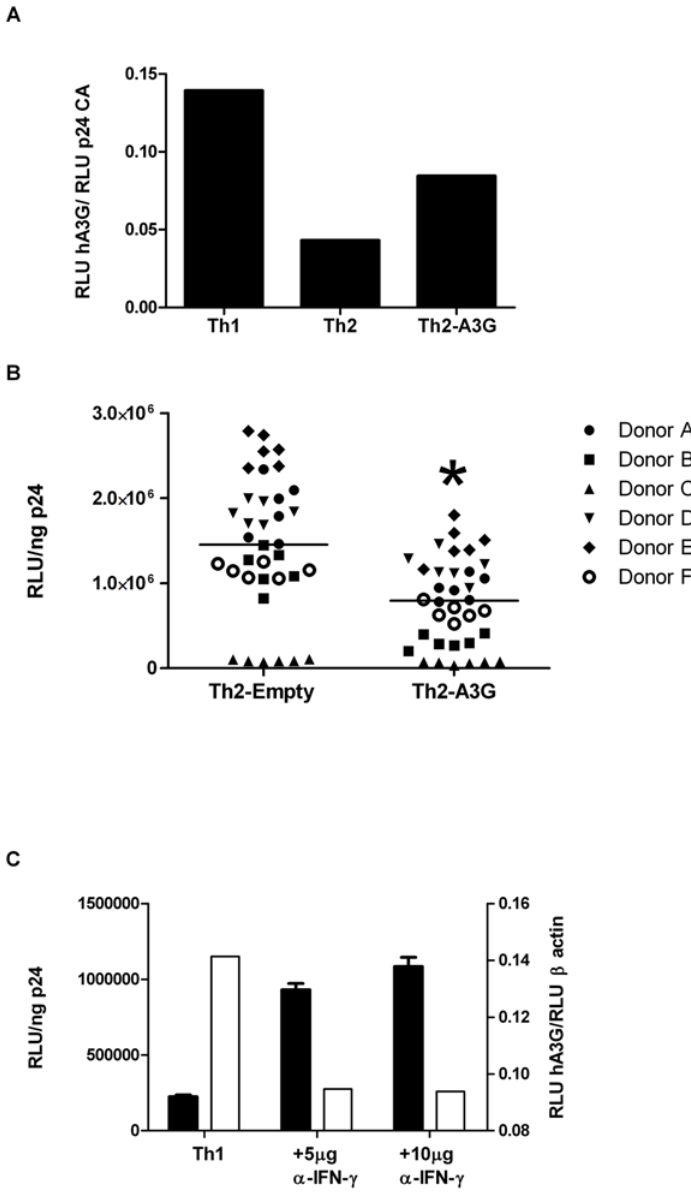
Figure 5. Evidence supporting a direct effect of hA3G on relative infectivity of HIV-1 virions produced from Th1 and Th2 cells. In vitro cytokine-derived Th2 cells were transduced with a control lentiviral vector (Th2-Empty) or a vector expressing hA3G (Th2-A3G). Protein levels of hA3G packaged into virions produced from Th1, Th2, and hA3G-transduced Th2 cells were determined by Western Blotting on the LICOR Odyssey system (Relative Light Units (RLU) of hA3G as normalized by HIV-1 p24 antigen) Shown is a representative blot of three experiments with similar trends. (A). The infectivity of vif -deleted HIV-1(NL4-3) virions produced from those cells from 6 donors was determined using the TZM-bl indicator cell line. Error bars represent median and interquartile range (*p=.03). (B) In vitro cytokine-derived Th1 cells were activated and incubated with either an isotype control or neutralizing IFN- c antibodies for 48 hours. Protein concentrations were determined by Western blot (C,open bars). The infectivity of vif -deleted HIV-1(NL4-3) virions produced from those cells was determined using the TZM-bl indicator cell line (C, closed bars).